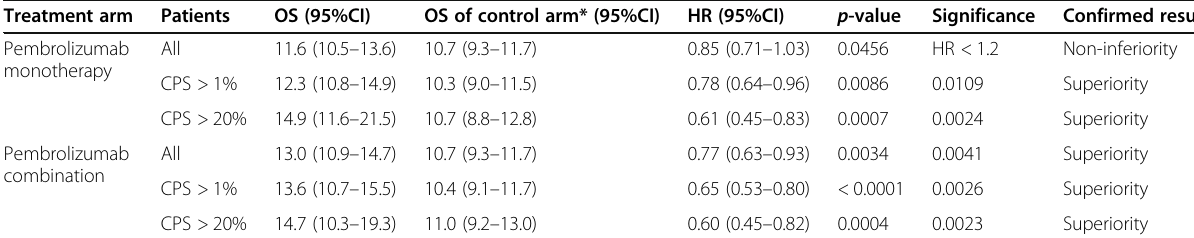
Table 2 The overall survival of the patients in the KEYNOTE-048 phase 3 trial comparing monotherapy with the anti-PD-1 antibody pembrolizumab and combination chemotherapy with cetuximab [53] Treatment arm Patients